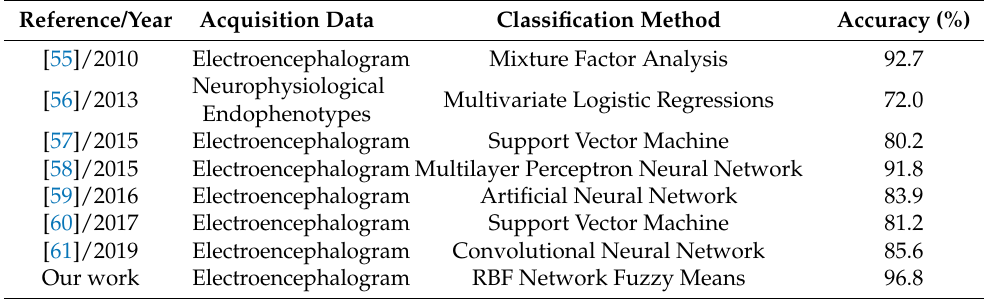
Table 6. Performance comparison of different classification methods presented in similar